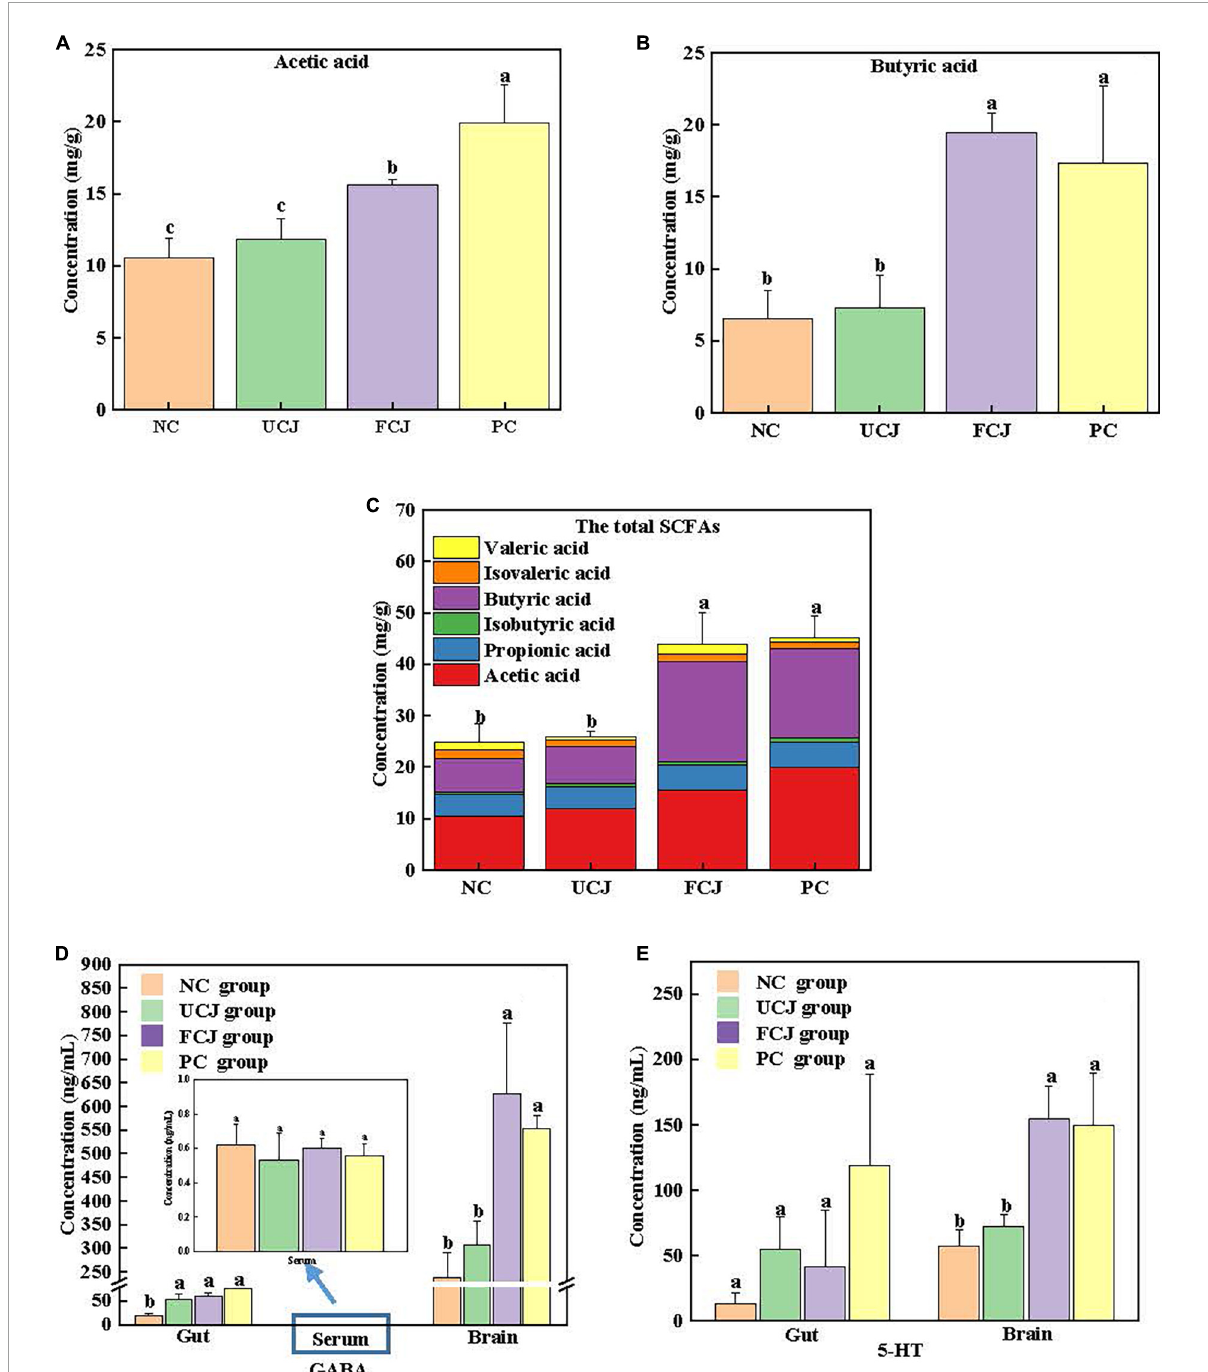
FIGURE3 The content of SCFAs and neurotransmitters in mice gut, serum, and brain. (A) The content of acetic acid in gut; (B) the content of butyric acid in gut; (C) the content of total SCFAs in gut; (D) the content of GABA in mice gut, serum, and brain; (E) the content of 5-HT in mice gut and brain. Different letters indicate significant difference ( p < 0.05). Six mice were randomly selected from each experimental group ( n =